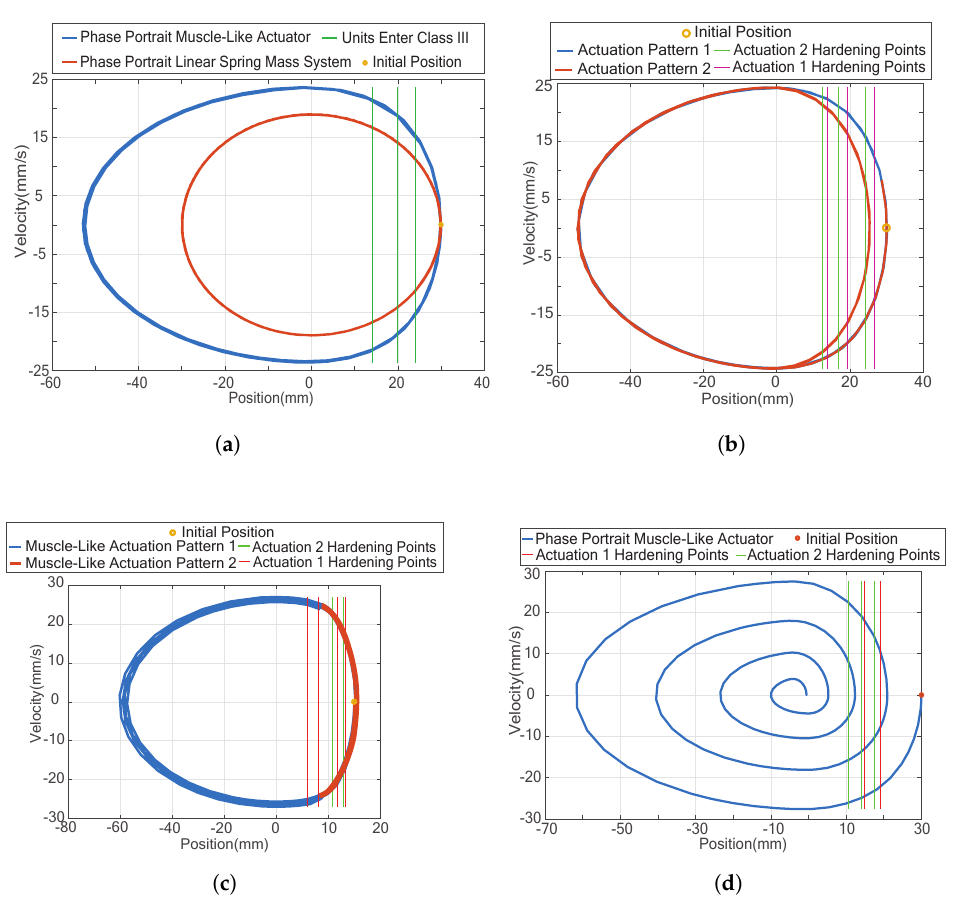
Figure 8. Actuator phase portraits of different switching patterns: ( a ) simple-harmonic motion of variable stiffness actuator; ( b ) switching based upon time; ( c ) switching based upon position; and ( d ) switching activation based upon